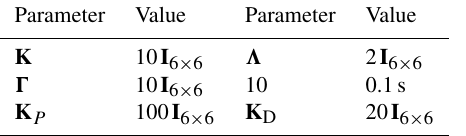
Table 2. Physical parameters of the proposed manipulator Parameter Value Parameter Value